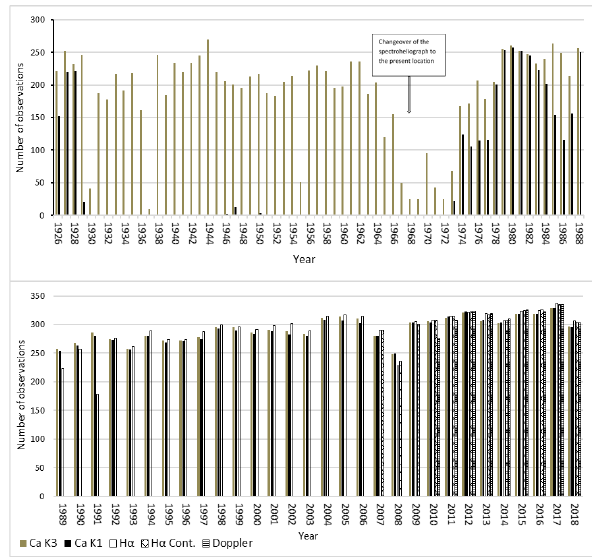
Figure 8. Number of observations at the COI since